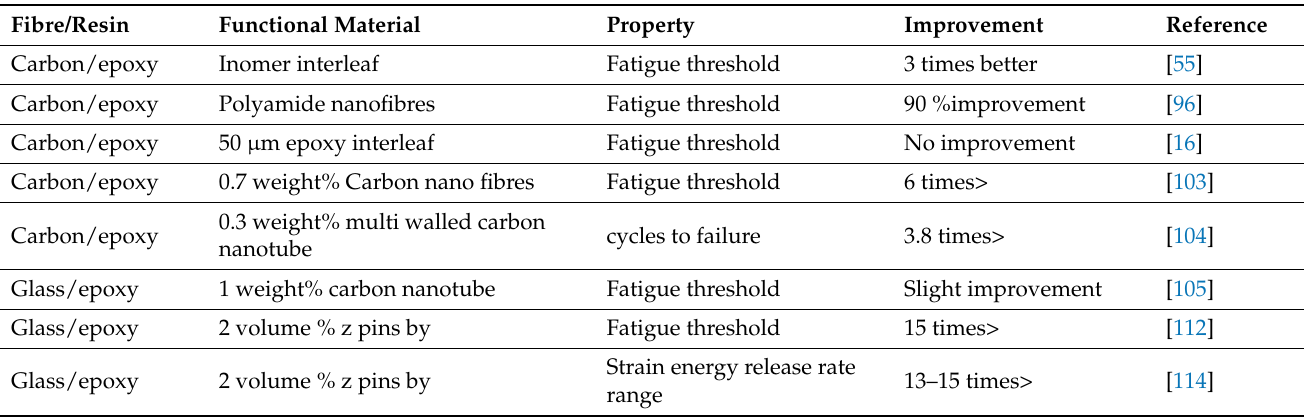
Table 2. Effect of matrix toughening, interleaving and z-pinning on mode I fatigue performance of